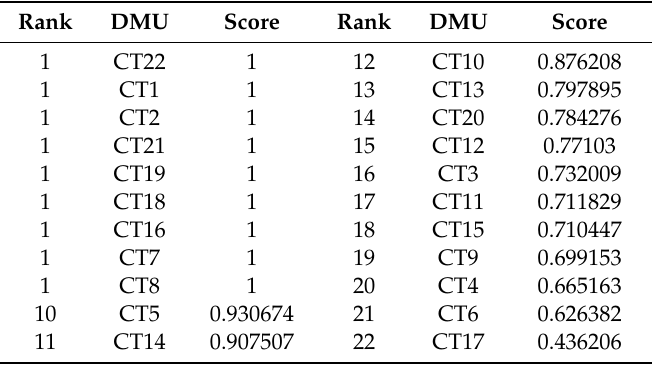
Table 4. E ffi ciency scores and ranking.